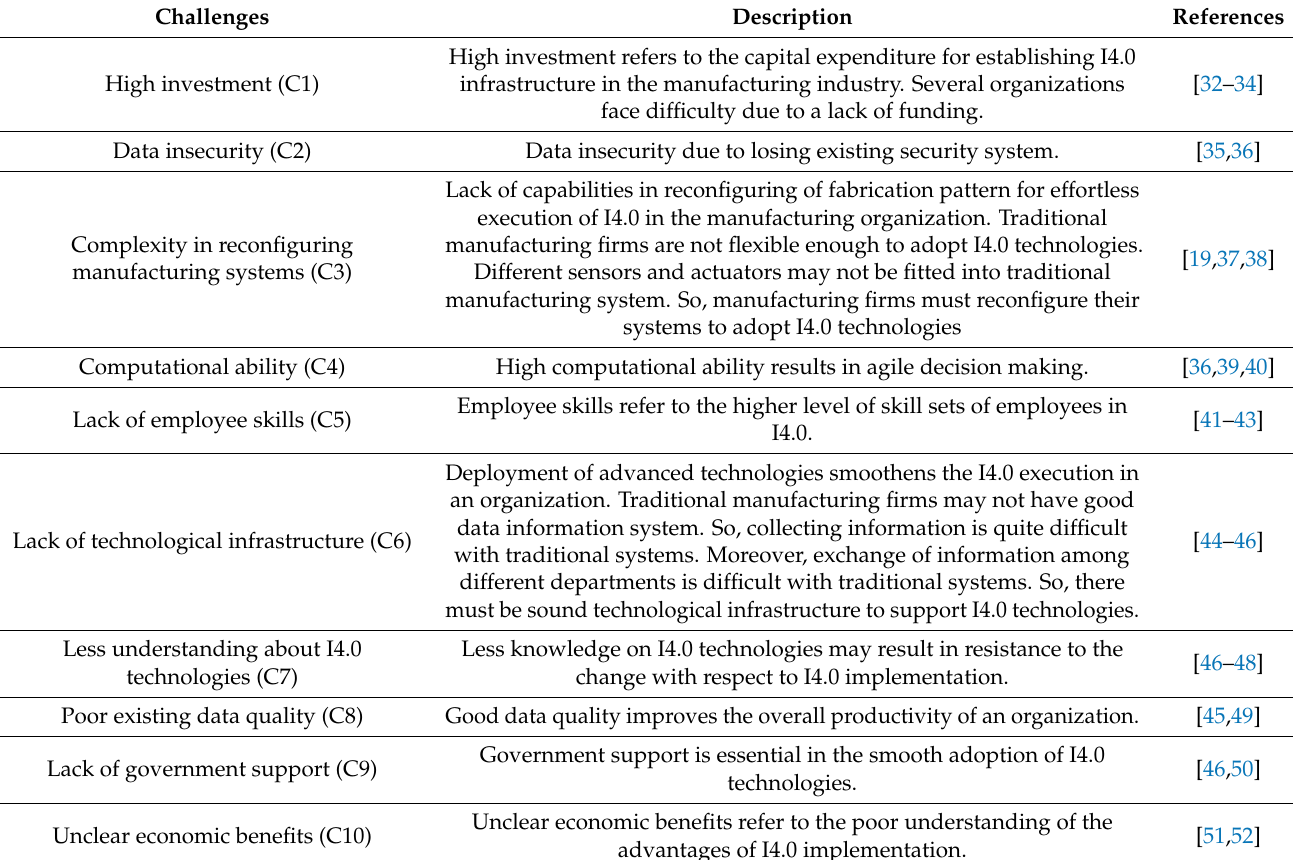
Table 1. I4.0 challenges for its adoption in the manufacturing